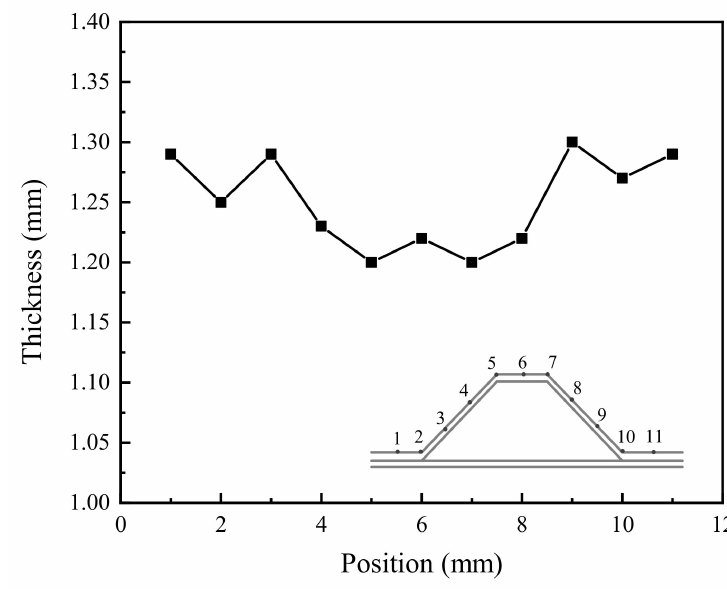
Figure 11. The thickness